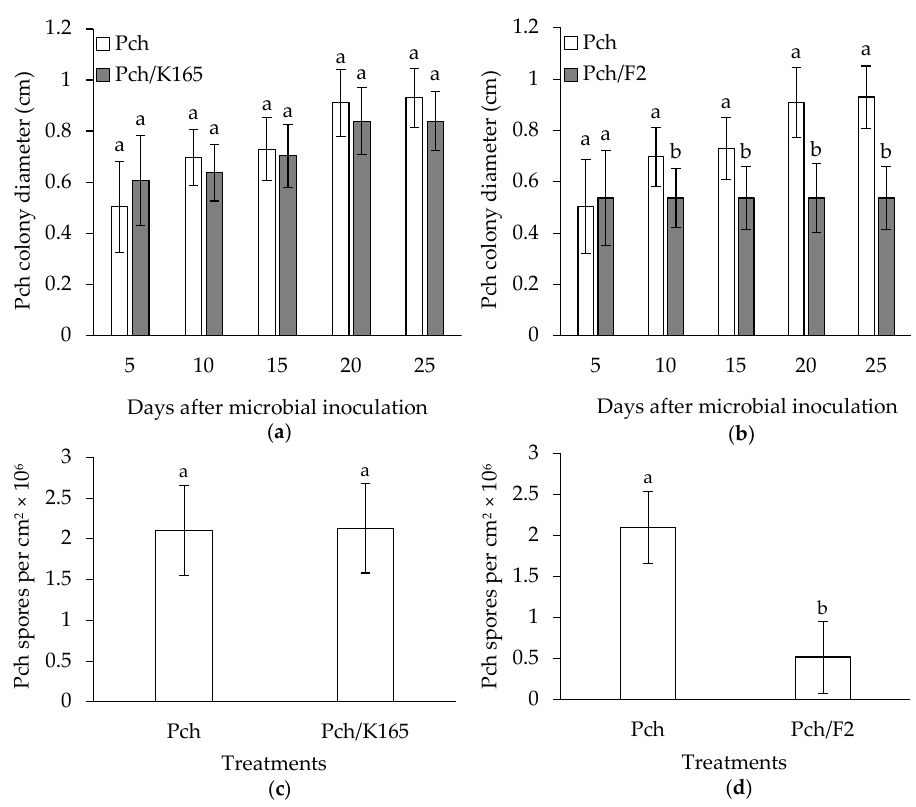
Figure 1. In vitro growth ( a , b ) and sporulation ( c , d ) of Phaeomoniella chlamydospora (Pch) in dual culture with Paenibacillus alvei K165 (Pch/K165) or Fusarium oxysporum F2 (Pch/F2) in agar medium simulating the xylem environment. The sporulation of Pch was assessed at 25 days after inoculation. The columns represent the means of three biological repeats ( n = 3) (with three plates per treatment and repeat). Columns (at each day for the in vitro growth experiment) with different letters are significantly different from each other, according to a t-test ( p < 0.05). The vertical bars indicate the standard difference value.